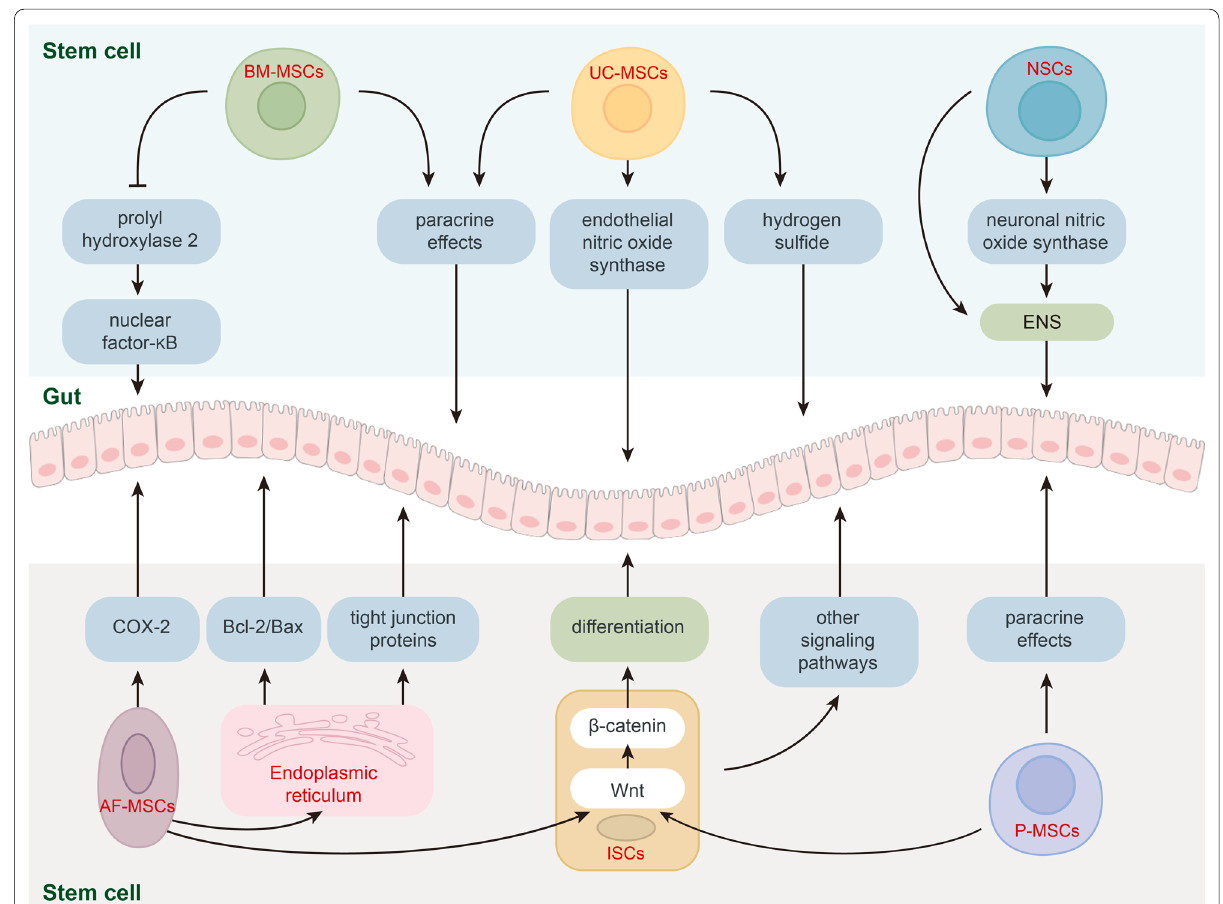
Fig. 2 The different types of stem cells used to treat NEC and their signaling pathways. Stem cells exert NEC therapeutic effects via various signaling pathways. Mainly, MSCs exert therapeutic effects through paracrine signaling. In addition, BM‑MSCs inhibit prolyl hydroxylase 2 to promote nuclear factor‑κB activation and increase the release of the intestinal protective factors. UC‑MSCs activate endothelial nitric oxide synthase and secrete hydrogen sulfide in NEC therapy. NSCs can repair and replenish neurons in the ENS, activate the neuronal nitric oxide synthase to prevent the ENS from being damaged, and preserve intestinal integrity. AF‑MSCs activate ER stress response to process the unfolded tight junction proteins and promote the expression of Bcl‑2/Bax gene. Moreover, AF‑MSCs increase the expression of COX‑2 in the lamina propria. AF‑MSCs and P‑MSCs restore the ISC niche to promote IECs proliferation with increased Wnt/β‑catenin signaling. ISCs are deservedly responsible for the differentiation to IECs via various signaling pathways. BM-MSCs bone marrow‑derived mesenchymal stem cells; UC-MSCs umbilical cord‑derived stem cells; NSCs neural stem cells; ENS enteric neural system; COX-2 cyclooxygenase 2; Bcl-2 B‑cell lymphoma 2; Bax Bcl‑2‑associated X protein; AF-MSCs amniotic fluid‑derived mesenchymal stem cells; ISCs intestinal stem cells; P-MSCs placental‑derived mesenchymal stem